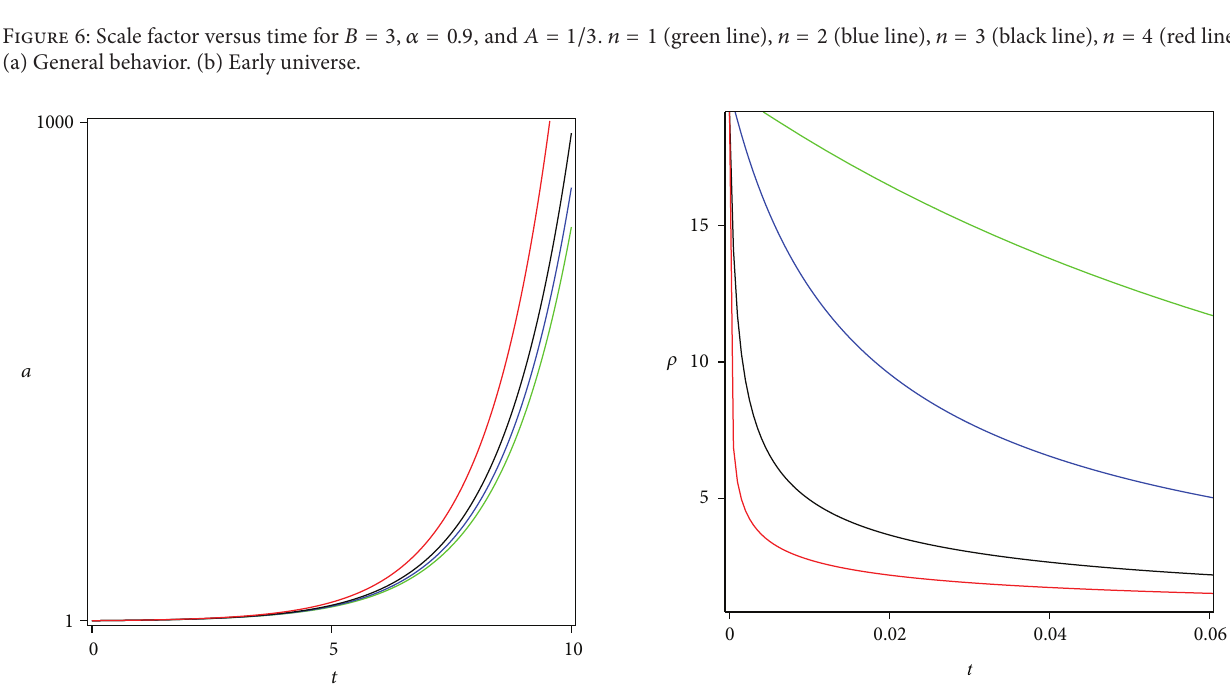
Figure 7: Scale factor versus time for 𝐵 = 3 , 𝑛 = 2 , and 𝐴 = 1/3 . 𝛼 = 0.9 (green line), 𝛼 = 0.7 (blue line), 𝛼 = 0.5 (black line), 𝛼 = 0.1 (red line).